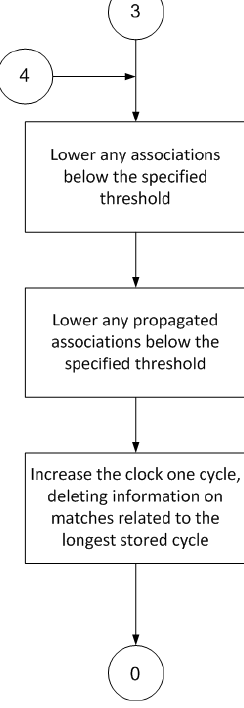
Figure 6. Deleted information (3 is the initial state of this diagram; state 4 comes from Figure 3; 0 is the final state of this diagram and it is the initial state of Figure 3 at the same time).